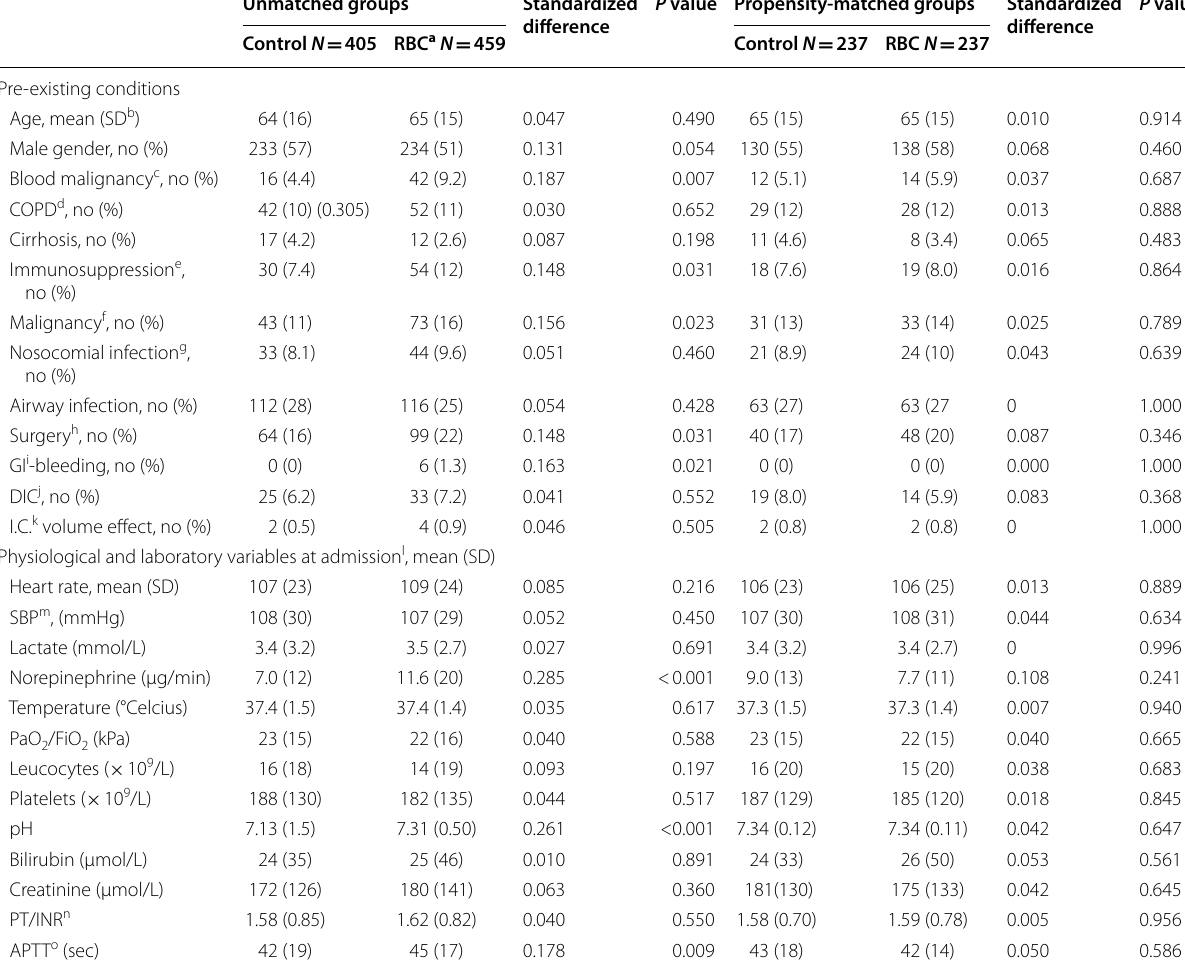
Table 1 Patient demographics before and after propensity